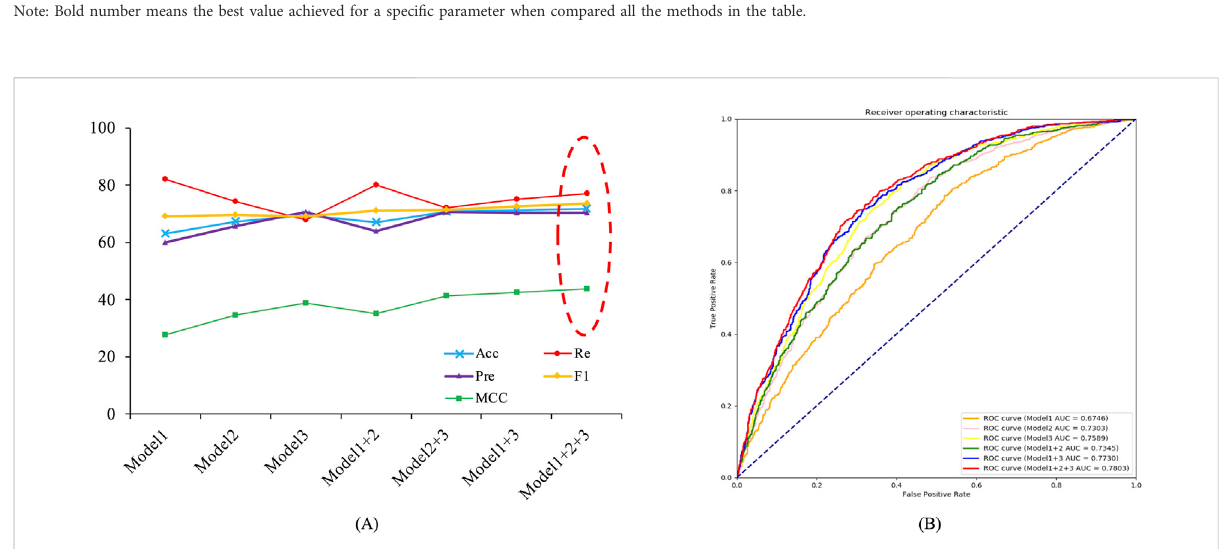
FIGURE 6 Line charts of voting results for different base models on independent test data. Model 1 denoted base classi fi er based on CTDC, Model 2 denoted base classi fi er based on the combination of APAAC and EGAAC, and Model 3 denotee based classi fi er based on embedding encoding. (A) Voting results for different combinations of models. (B) ROC curves and AUC values for different combinations of